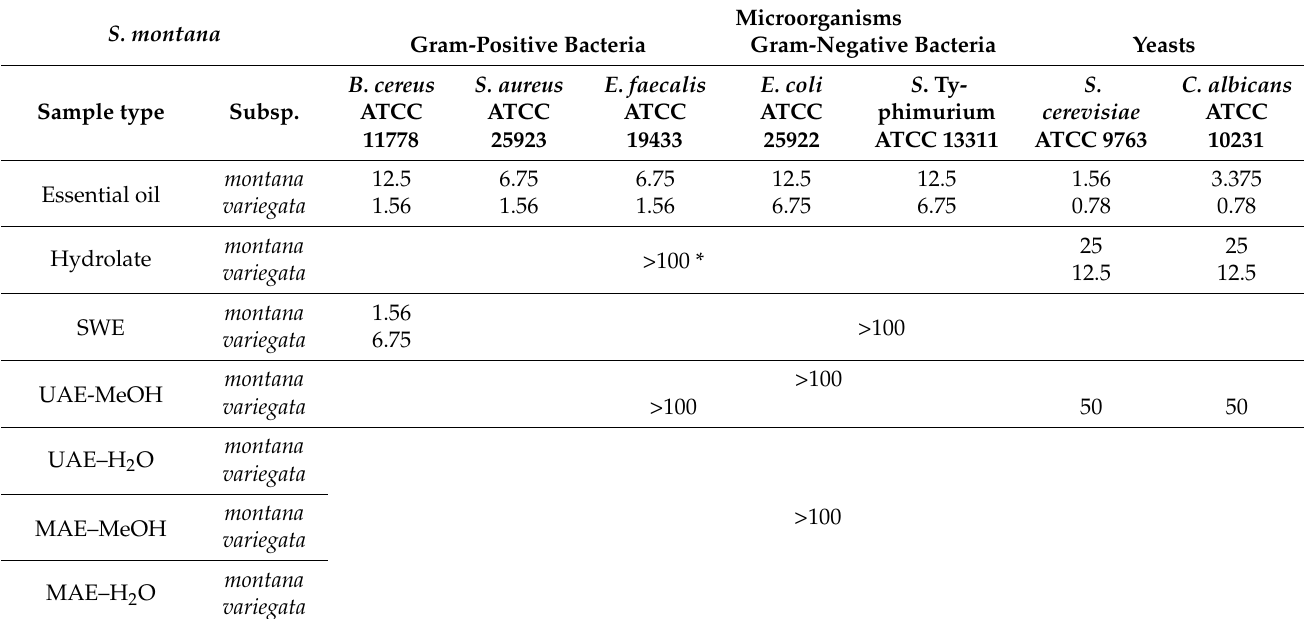
Table 2. Minimal inhibitory concentration (%)